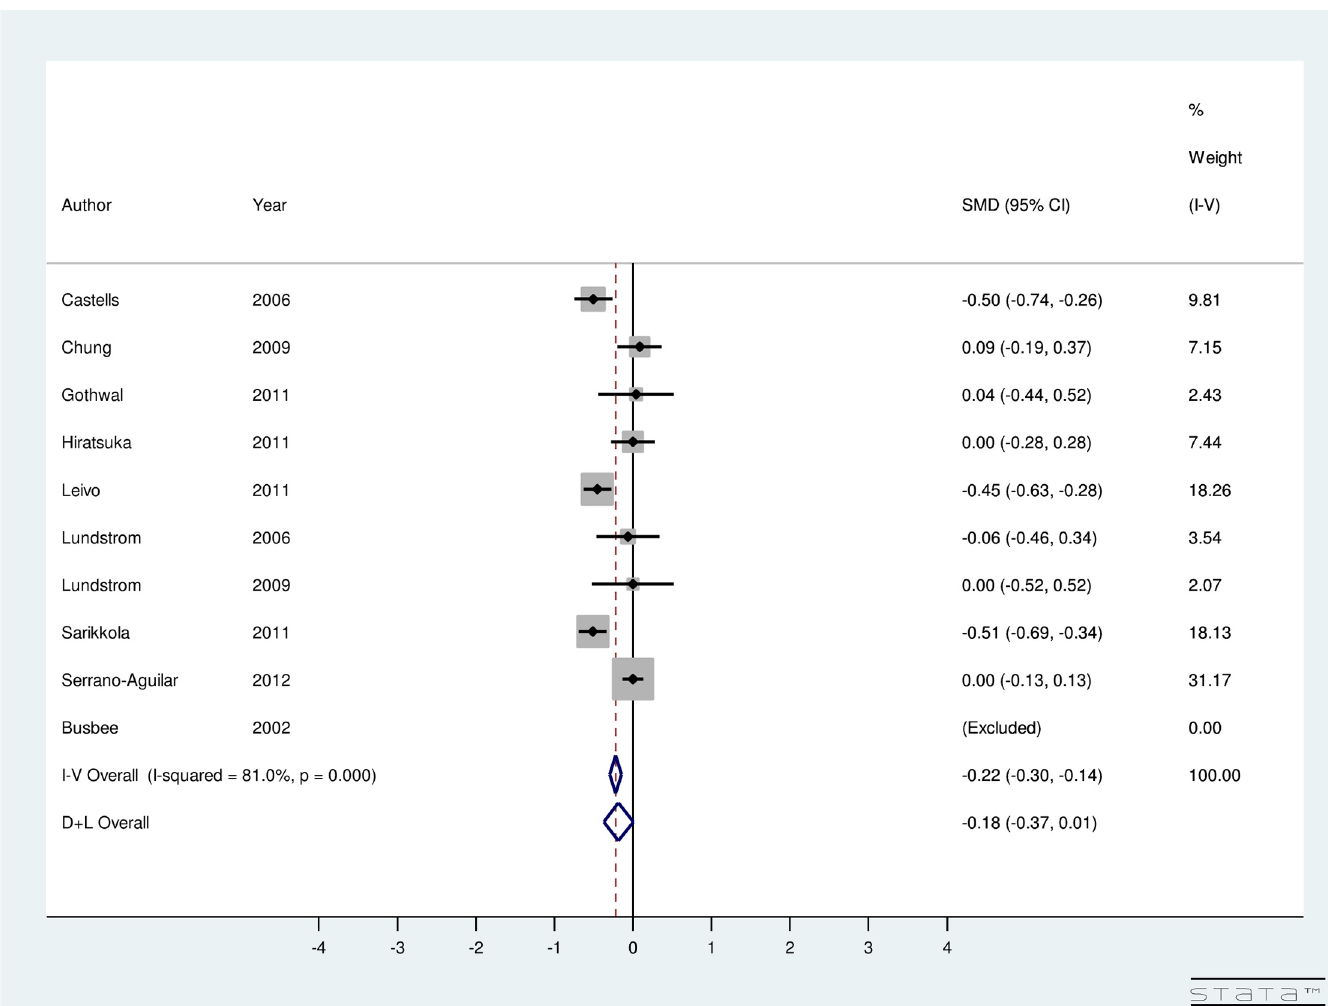
Fig 8. Forest Plot showing Improvement in Best Corrected Visual Acuity Due to Immediately Sequential Bilateral Cataract Surgery versus Delayed Sequential Bilateral Cataract